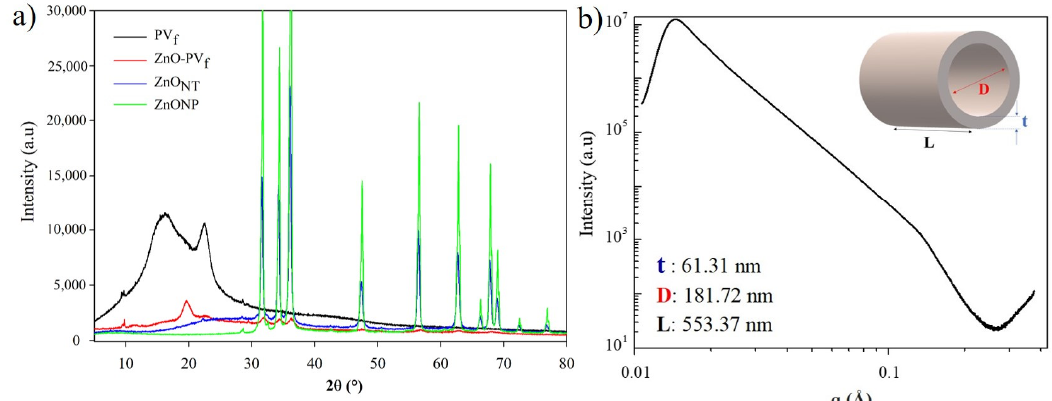
Figure 4. ( a ) XRD diffraction patterns of electrospun polyvinyl alcohol (PV) fibers (PV f ), coated nanofibers (ZnO-PV f ), hollow zinc oxide nanotubes (ZnO NT ), and commercial zinc oxide nanoparticles (ZnONP); ( b ) I(q)-q plot of ZnO NT structure obtained by small-angle X-ray scattering (SAXS).